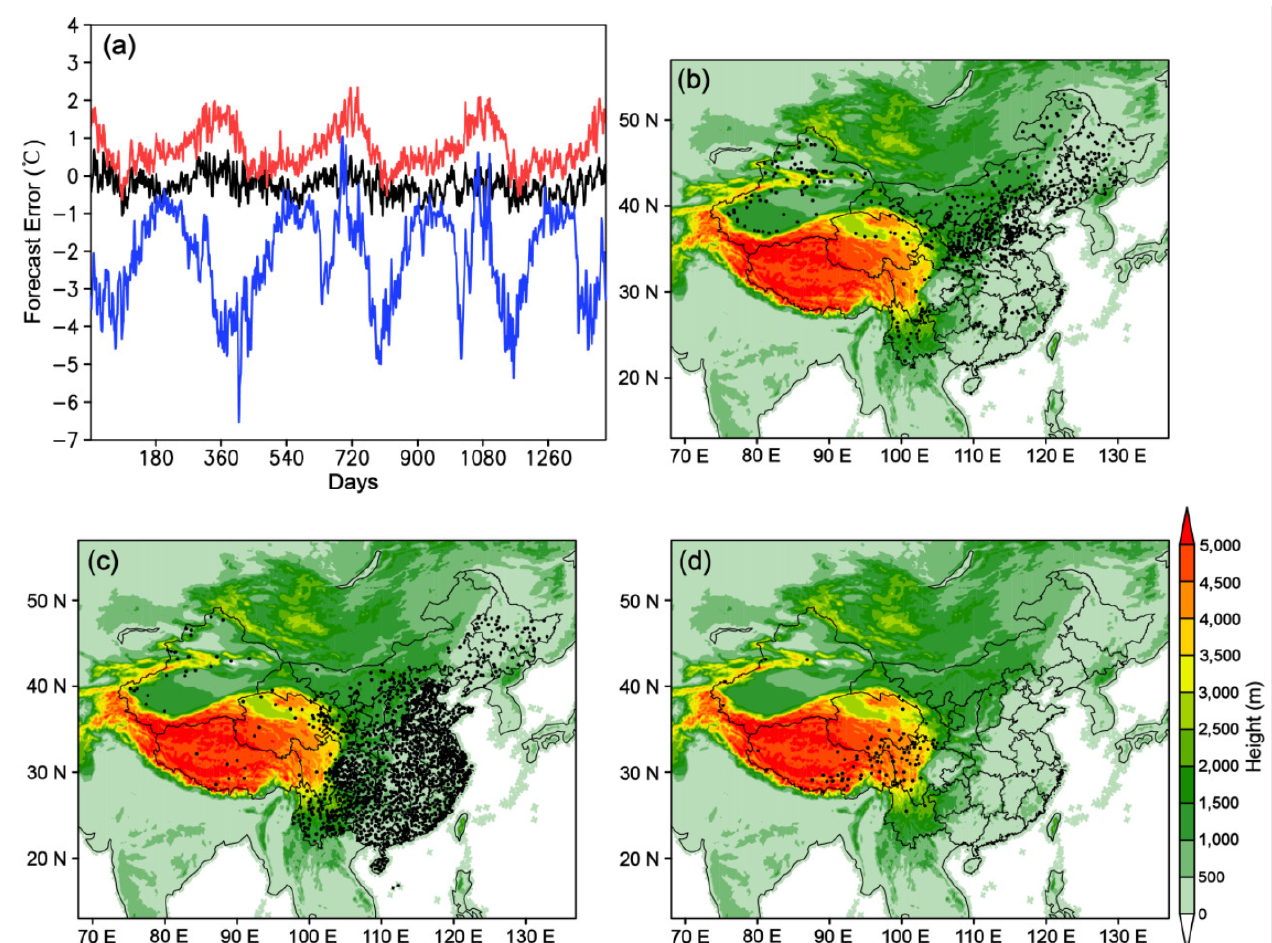
Figure 1. ( a ) Classification of the 2 m temperature forecast errors (units: ◦ C) of the surface stations in China from 2015 to 2018 using the K-means clustering method. ( b – d ) Distributions of the surface stations presenting the three categories of 2 m temperature forecast errors that are shown in (a) (the red, black and blue contours, respectively). The color-shaded in ( b – d ) are topographic heights (units: